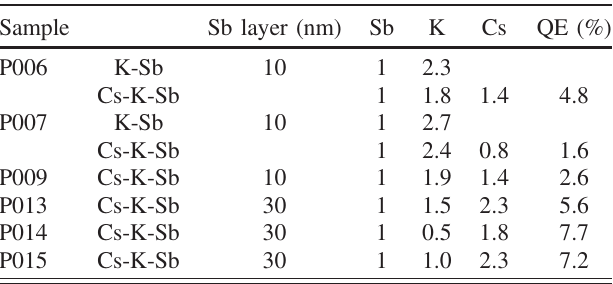
TABLE I. Chemical composition, thickness of the initial Sb layer, and final QE of the sequentially and codeposited samples. The QE is measured at 2.33 eV, as